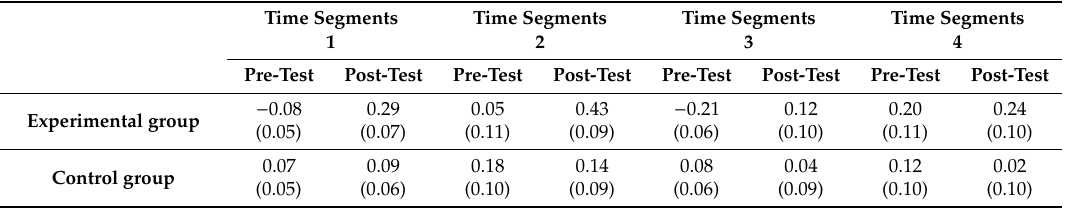
Table 5. The values of oxy-Hb for each of the four 90 s time segments in the 1-back task, M (SD). Time Segments Time Segments Time Segments Time Segments 1 2 3 4 Pre-Test Post-Test Pre-Test Post-Test